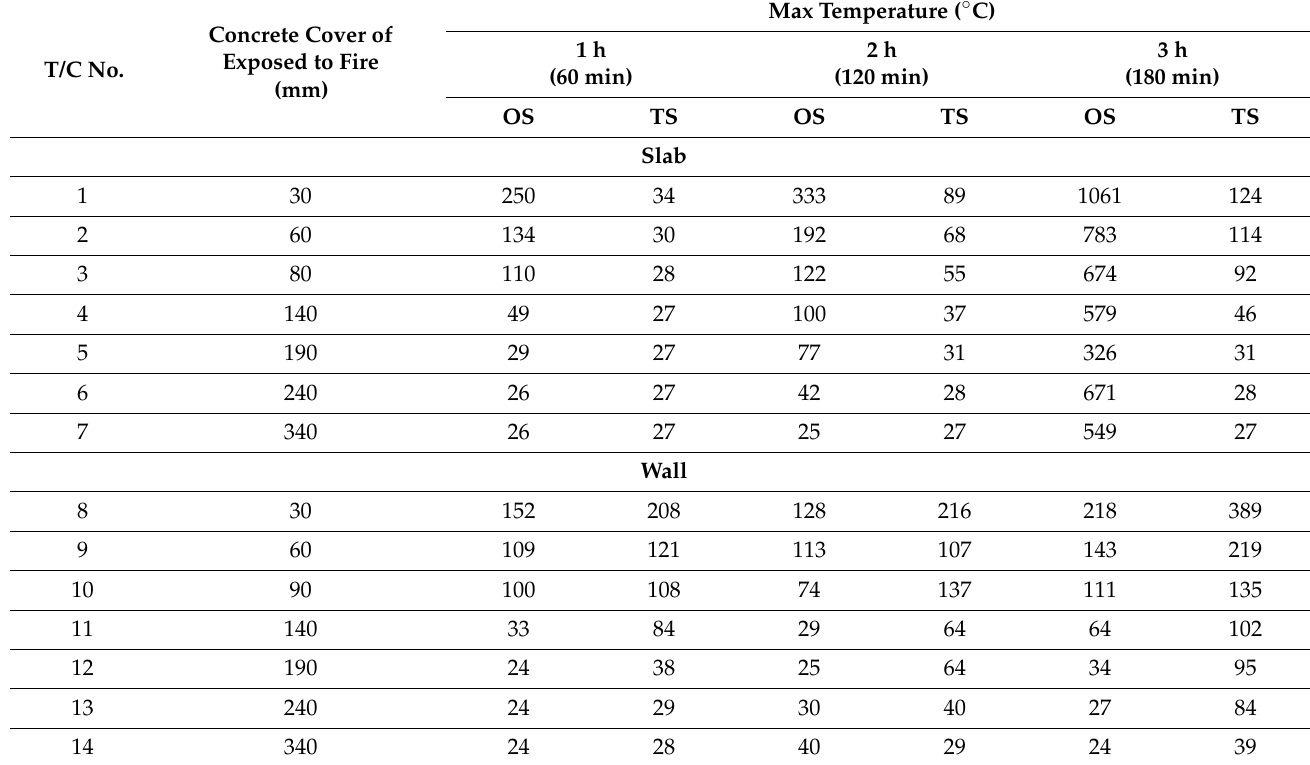
Table 9. The temperature of inner concrete and